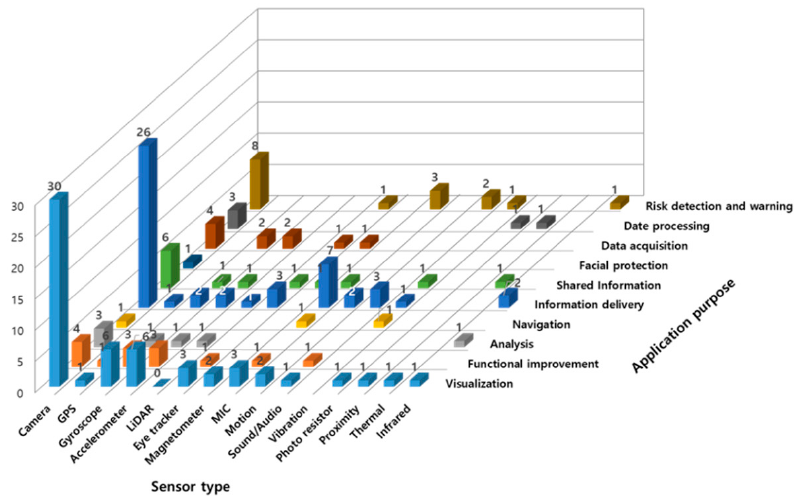
Figure 16. Frequency and ratio of each sensor used in the study.